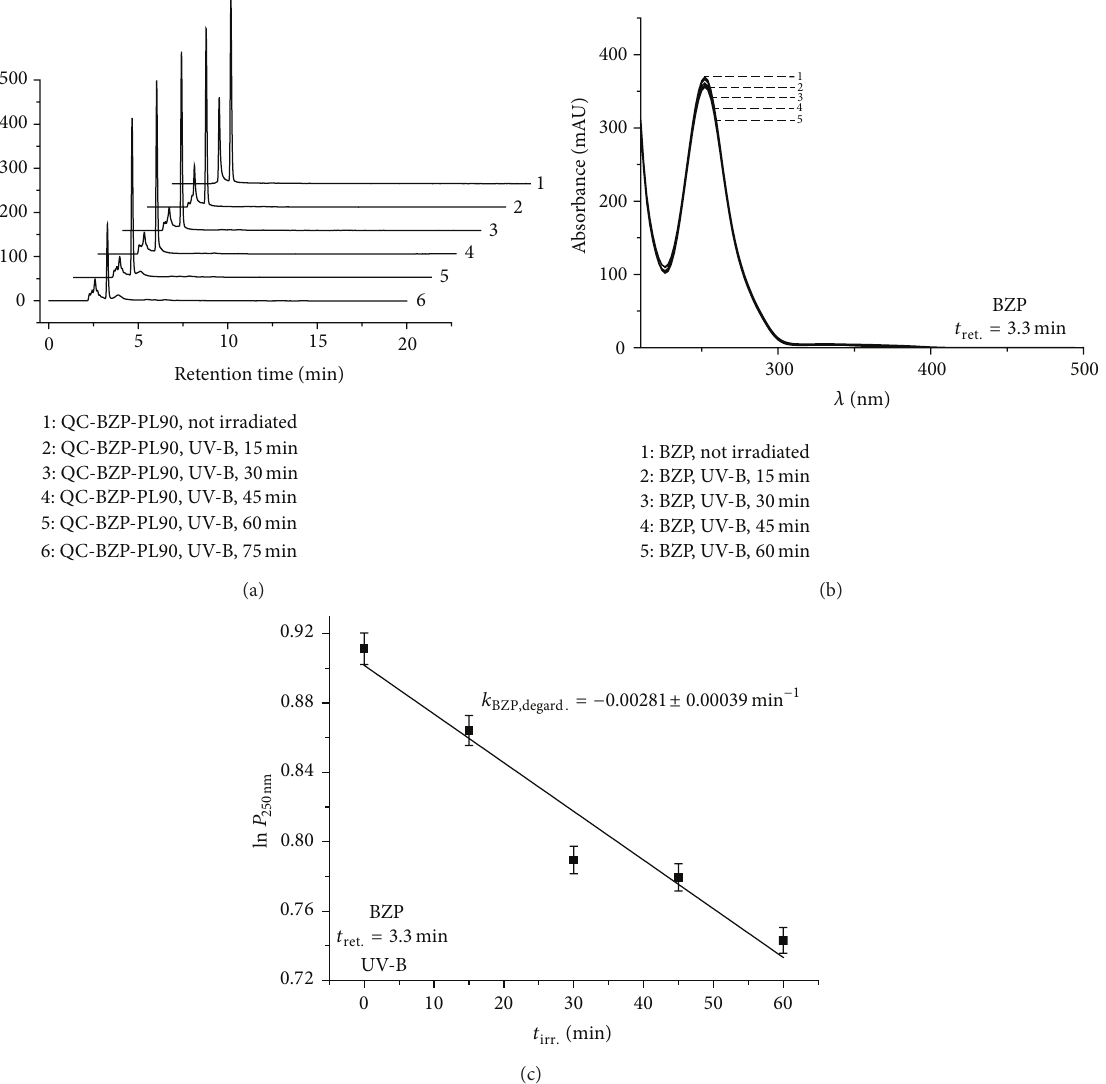
Figure 3: Degradation (bleaching) of benzophenone from the UV-B-irradiated sample, that is, quercetin/BZP/phospholipids mixture in methanol. (a) The recorded samples chromatograms recorded at 250 nm (BZP retention time, 𝑡 spectra taken from the upper (a) chromatogram (BZP peak at 𝑡 Kinetics of UV-B irradiation-induced bleaching, followed through a decrease of BZP peak ( 𝑡 increased UV-B irradiation periods, ln 𝑃 250 the